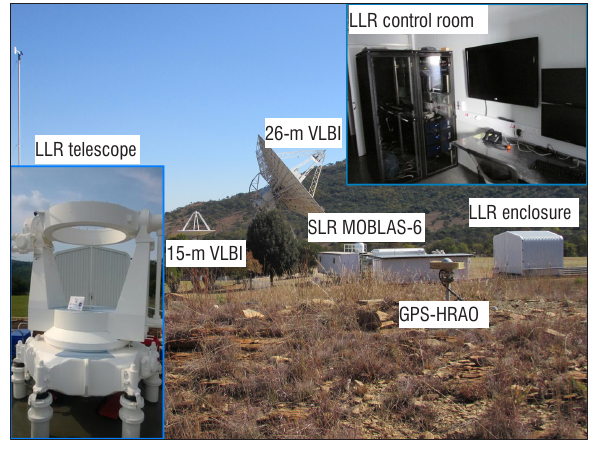
Figure 1: Geodetic instruments collocated at HartRAO, South Africa. The lunar laser ranging (LLR) azimuth-elevation mount is portrayed in the inset on the left; the tube and other components were removed for upgrade and maintenance. The top right inset depicts the inside of the LLR control room.